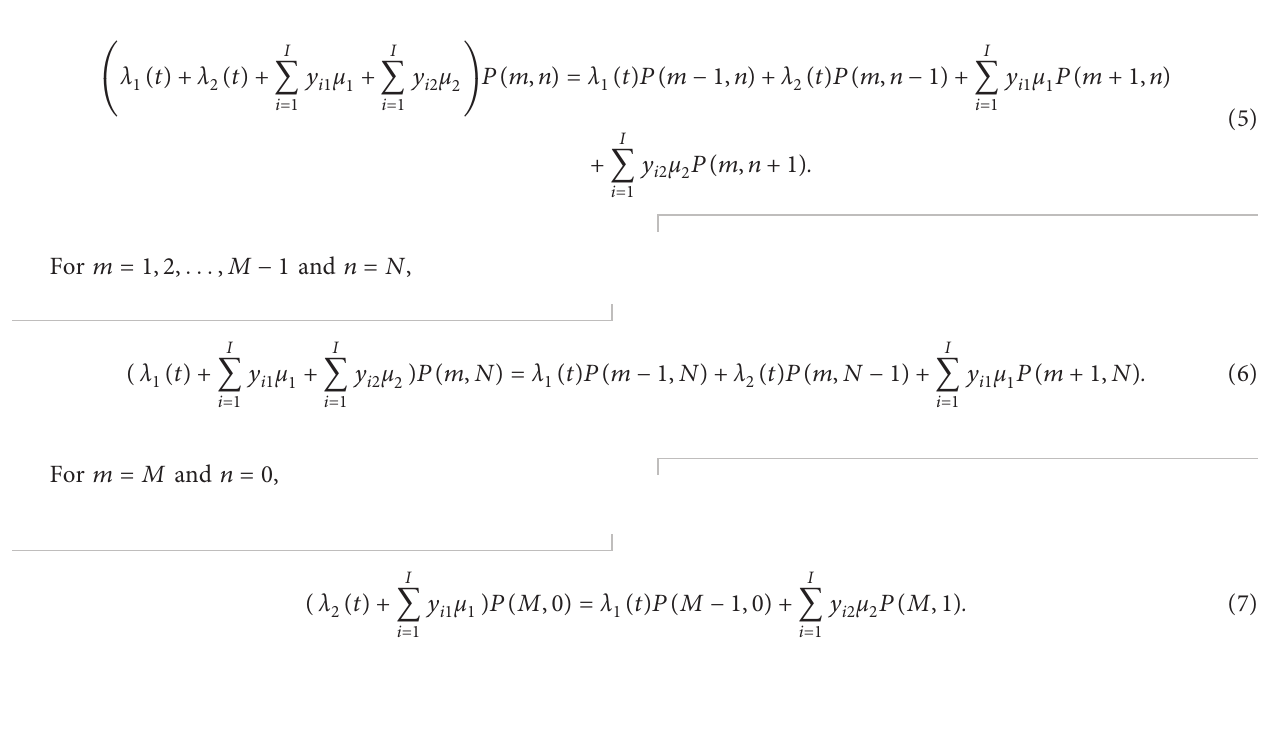
Figure 3: The state transition diagrams of the two types of